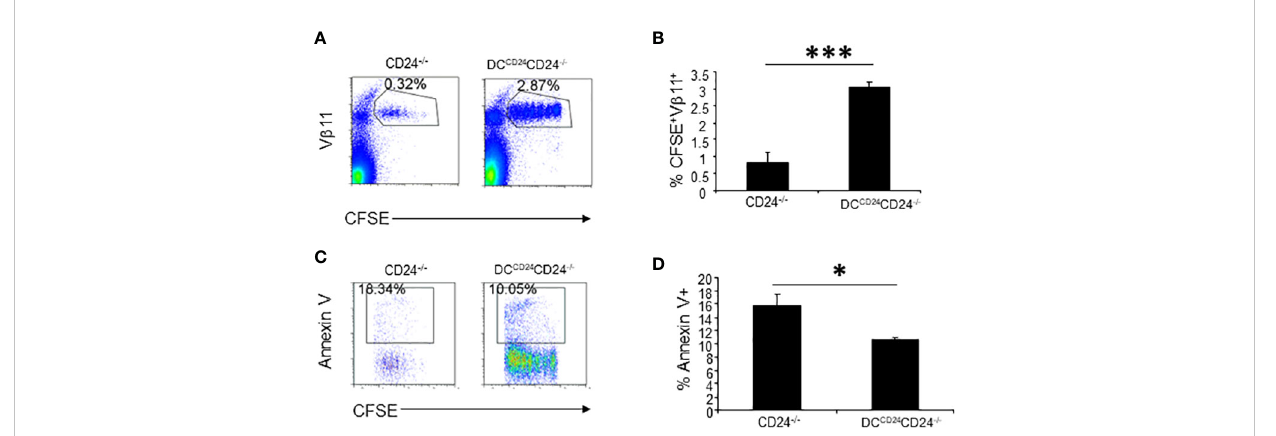
FIGURE 7 CD24 expression on DC contributes to proliferation and survival of 2D2 T cells. 5 x 10 6 of CFSE-labeled 2D2 T cells were injected into DC CD24 CD24 -/- or CD24 -/- mice i.v. followed by immunization with MOG 35-55 emulsi fi ed in CFA. Representative staining (A) and quanti fi cation of % CFSE + V b 11 + cells (B) are shown. Five mice per group were used in this experiment and data shown are Mean ± SD. ***P < 0.001. Student ’ s t test was used for the statistical analysis. (C, D) . Apoptosis of 2D2 T cells was quanti fi ed at 65 h after immunization with MOG 35-55/CFA. Five mice per group were used for this experiment. Data shown are Mean ± SD. Student ’ s t test was used for the statistical analysis. Data represent two experiments with similar results. *P <